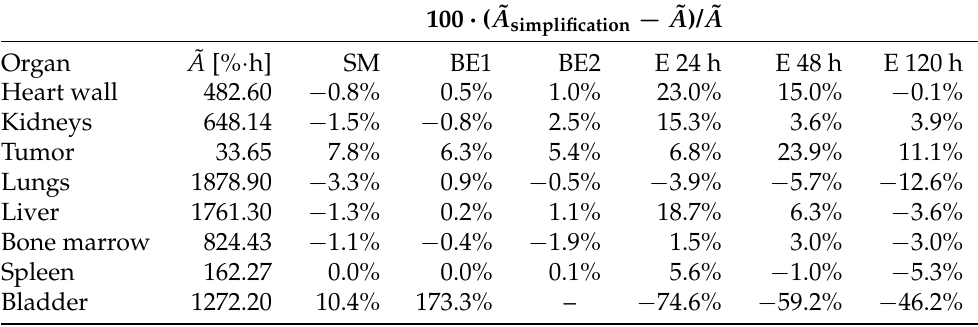
Figure 6. Comparison of best fits of time activity curves (kidneys, panels ( a , d ); tumor, panels ( b , e ); excreted activity , panels ( c , f )) obtained with the full model and different approximations: “FM” (full model); “SM” (simplification of the full model without slow components except for RT and tumor); “BE1” (biexponential fit with the entire dataset); “BE2” (biexponential fit with only 4 points at [2, 24, 120, 505] h); “E 24 h”, “E 48 h”, “E 120 h” (exponential fits considering the physical decay of activities measured 24 h, 48 h, and 120 post-injection, respectively). Table 5. Relative differences in calculated cumulated activities of 131 I-CLR1404 in several organs obtained with the full biokinetic model presented in this work ( ˜ A ) and several simplifications: “SM” (simplification of the full model without slow components except for RT and tumor); “BE1” (biexponential fit with the entire dataset); “BE2” (biexponential fit with only 4 points at [2, 24, 120, 505] h); “E 24 h”, “E 48 h”, “E 120 h” (exponential fits considering the physical decay of activities measured 24 h, 48 h, and 120 h post-injection,